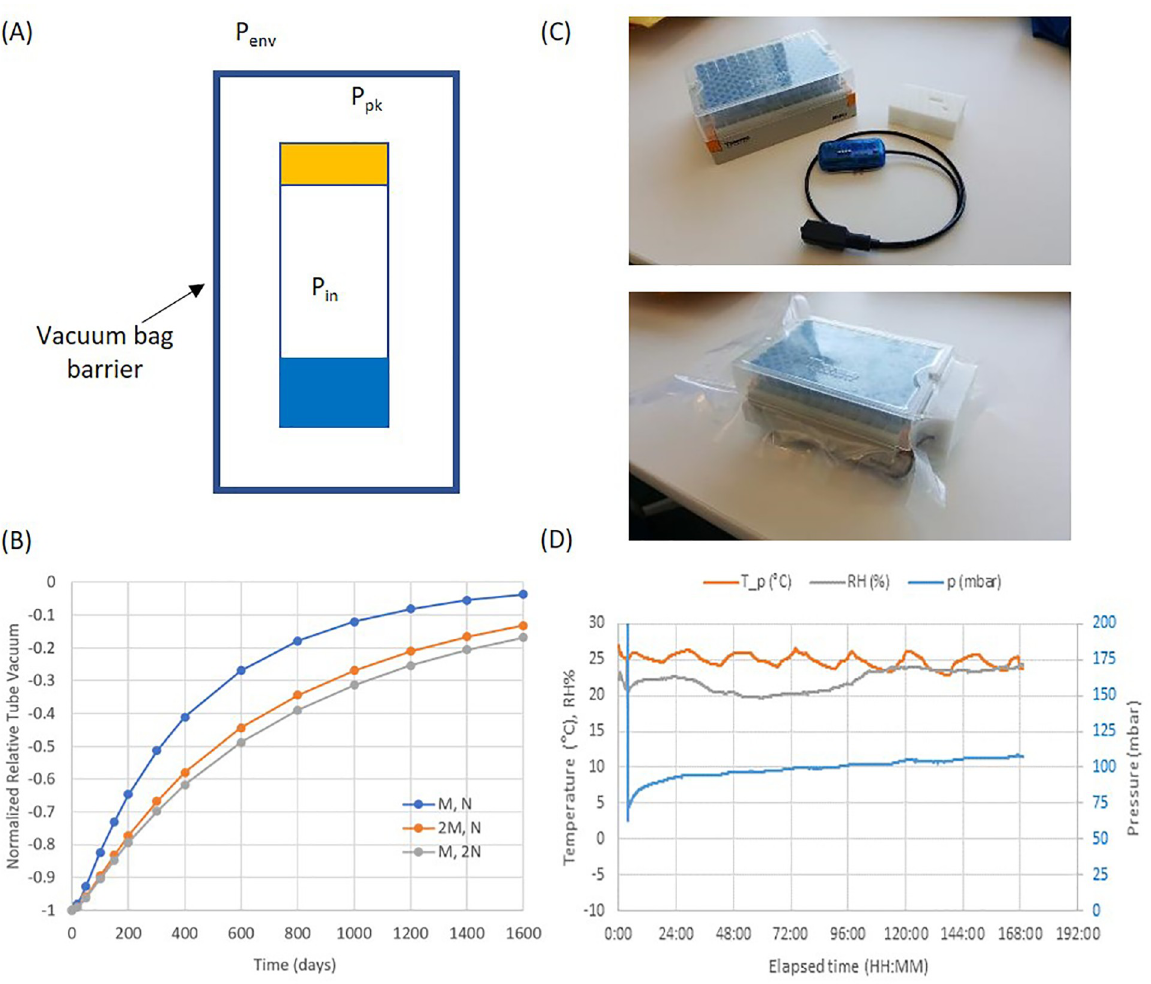
Fig 5. Packaging of VacuStor tubes inside a container by vacuum bag sealing. (A) Schematics; (B) Theoretical glass VacuStor tube vacuum decay for different M and N values; (C) Experimental setup showing a 96-tube rack with a data logger being sealed within a vacuum bag and a plastic fixture to prevent data logger buttons being pressed by the vacuum bag after sealing; (D) logger data showing how the container pressure P pk changed after sealing for 7